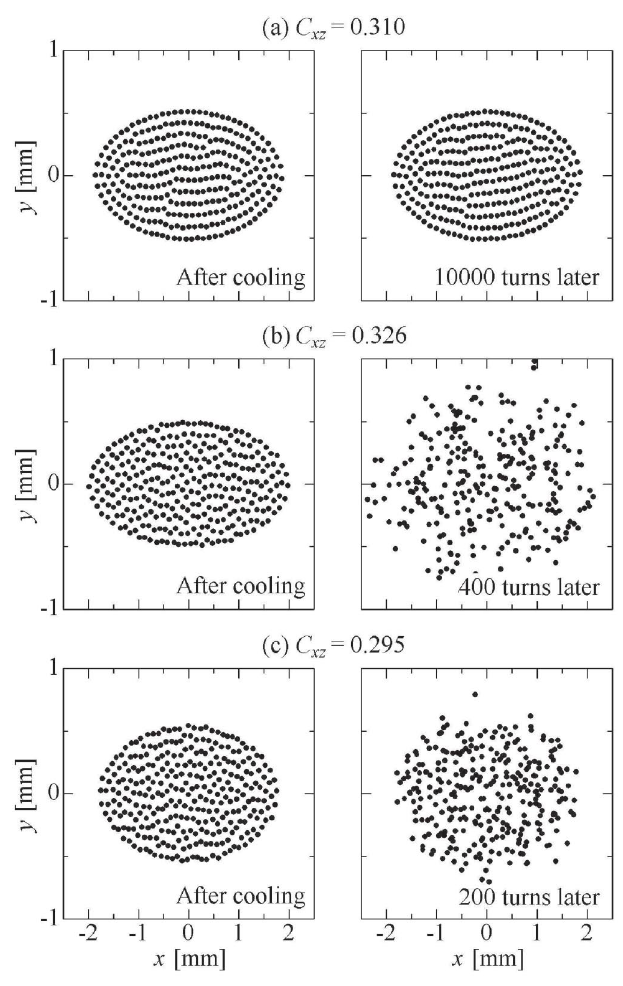
FIG. 7. Cross-sectional views of ultralow-emittance 24 Mg (cid:4) beams circulating in S-LSR at the kinetic energy of 35